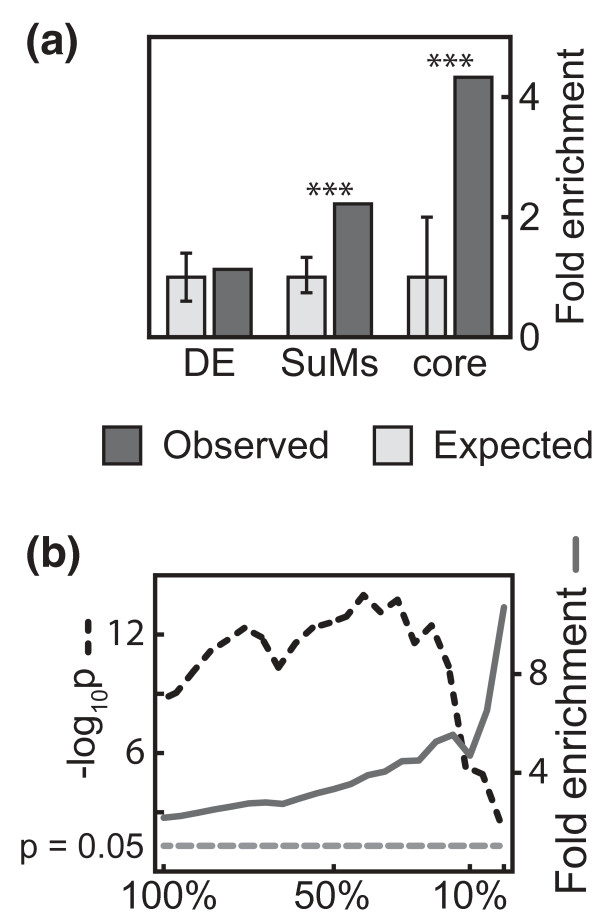
Enrichment of GWAS genes from 13 oncological, immunological and metabolic diseases in SuMs and core SuMs. (a) The enrichment of GWAS genes in core SuMs was stronger when the cutoff was more restrictive. The 10% cutoff was chosen to define core SuMs. (b) SuMs and core SuMs show strong enrichment of GWAS genes compared to differentially expressed (DE) genes. Error bars represent the 95% confidence interval of the randomized selections. Asterisks represent p < 0.001.